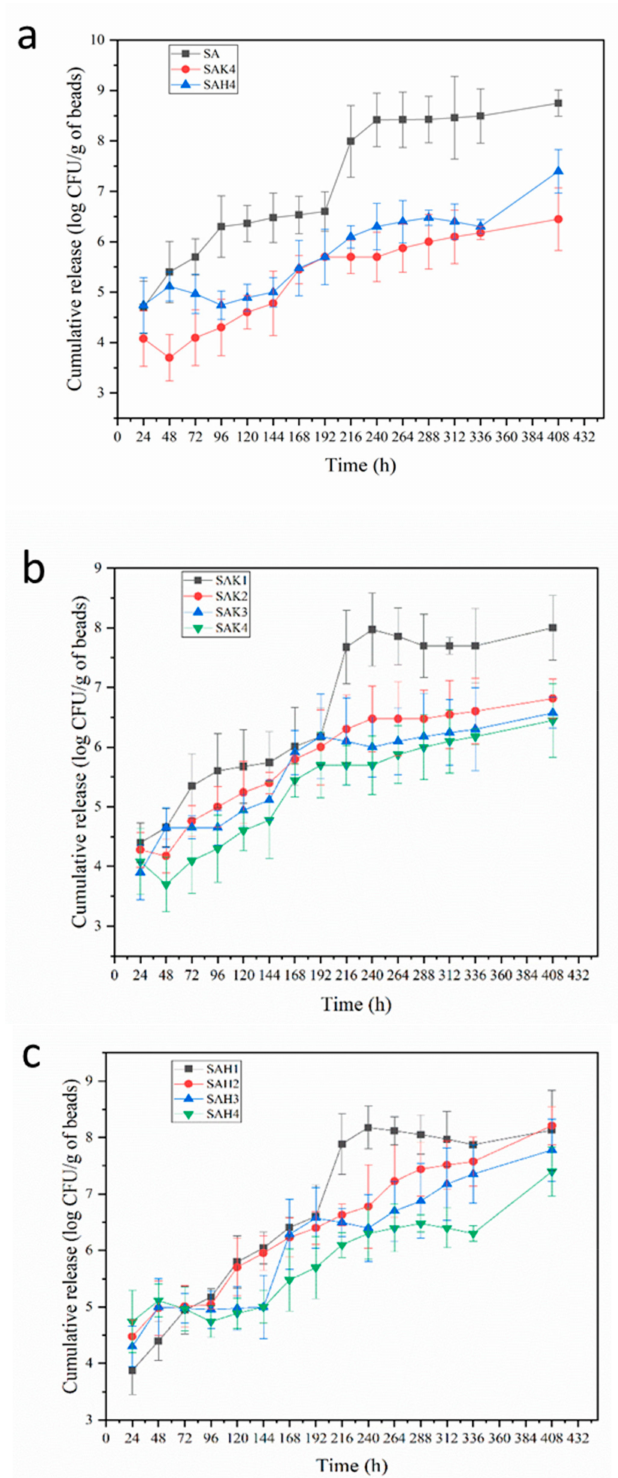
Figure 6. Cumulative release of spores from starch–alginate based beads: ( a ) With di ff erent formulations ( b ) With di ff erent kaolin contents ( c ) With di ff erent rice husk powder